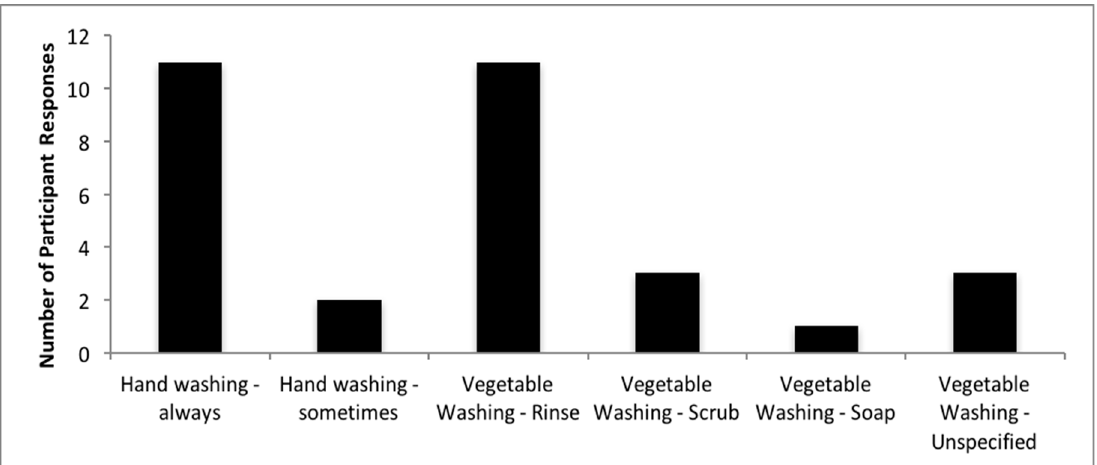
Figure 2. Hand and vegetable washing after gardening activities.